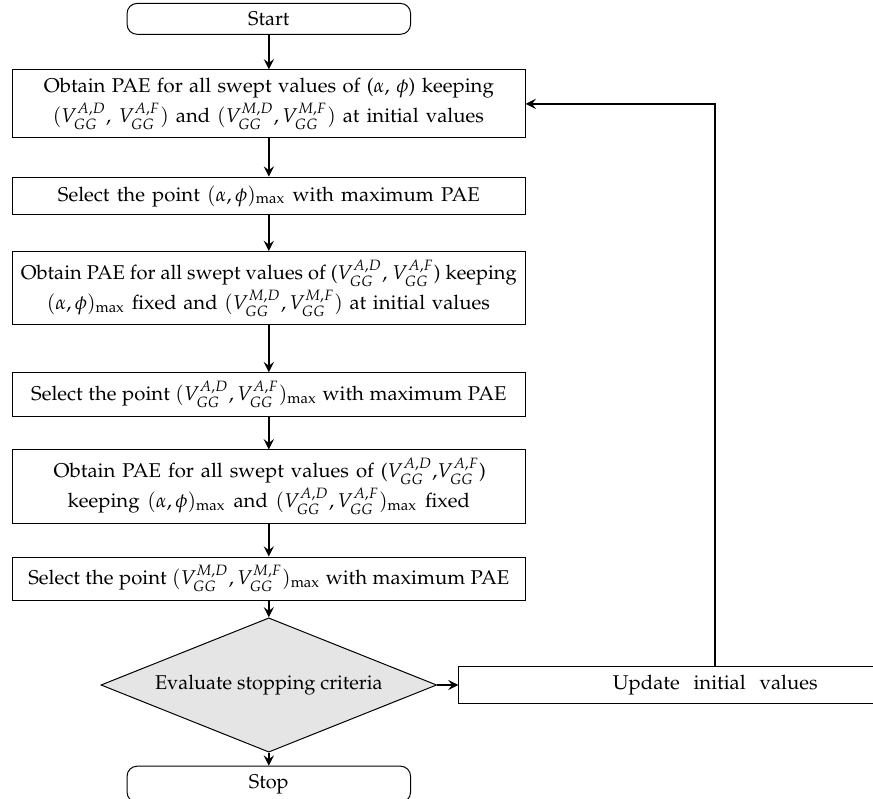
Figure 5. Flow chart for the coordinate descent optimization algorithm for the case of descent order ( α , φ ) → ( V A , D , V A , F ) → ( V M , D , V M , F GG GG GG GG